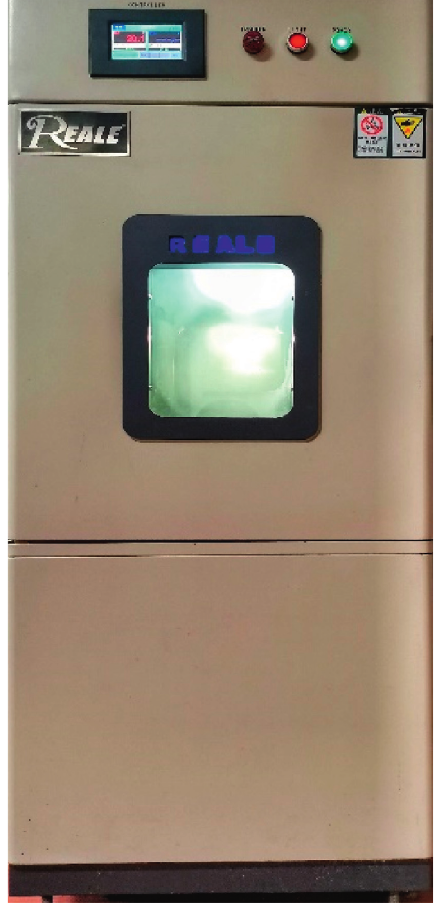
Figure 2: The constant temperature-humidity